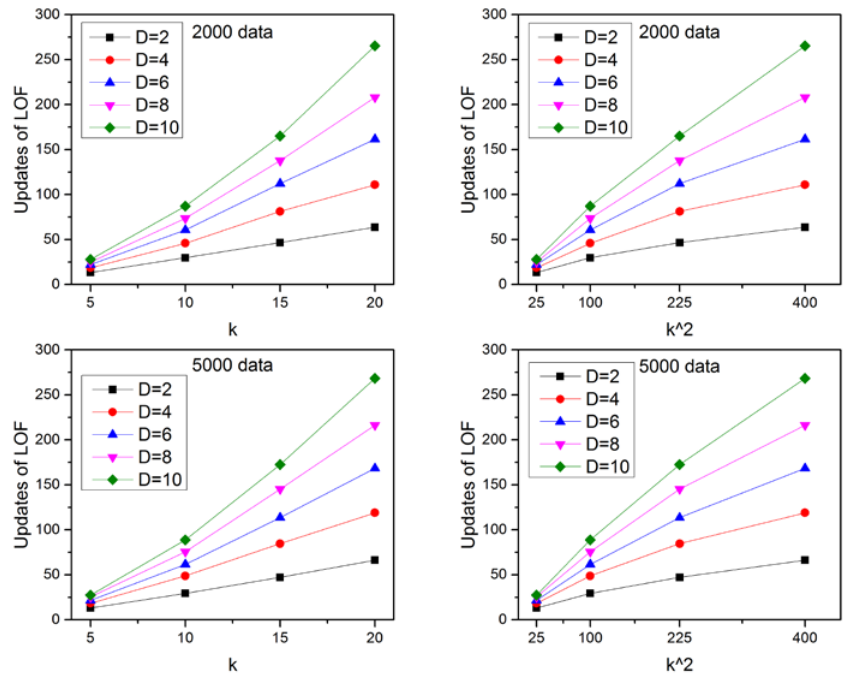
Figure 6. The dependence of the number of CLOF updates on data dimension D and parameter k simulated from a uniform distribution.